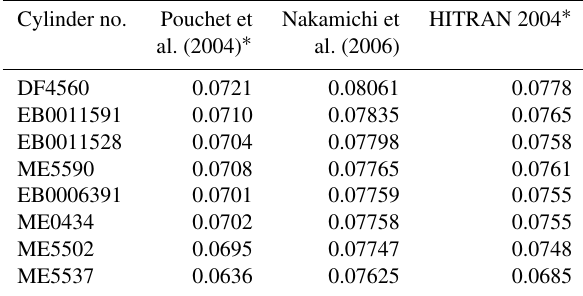
Table 5. Summary of N 2 -, O 2 -, and Ar-related pressure broadening coefficients in cm − 1 atm − 1 . All parameters were taken by using the Voigt function.